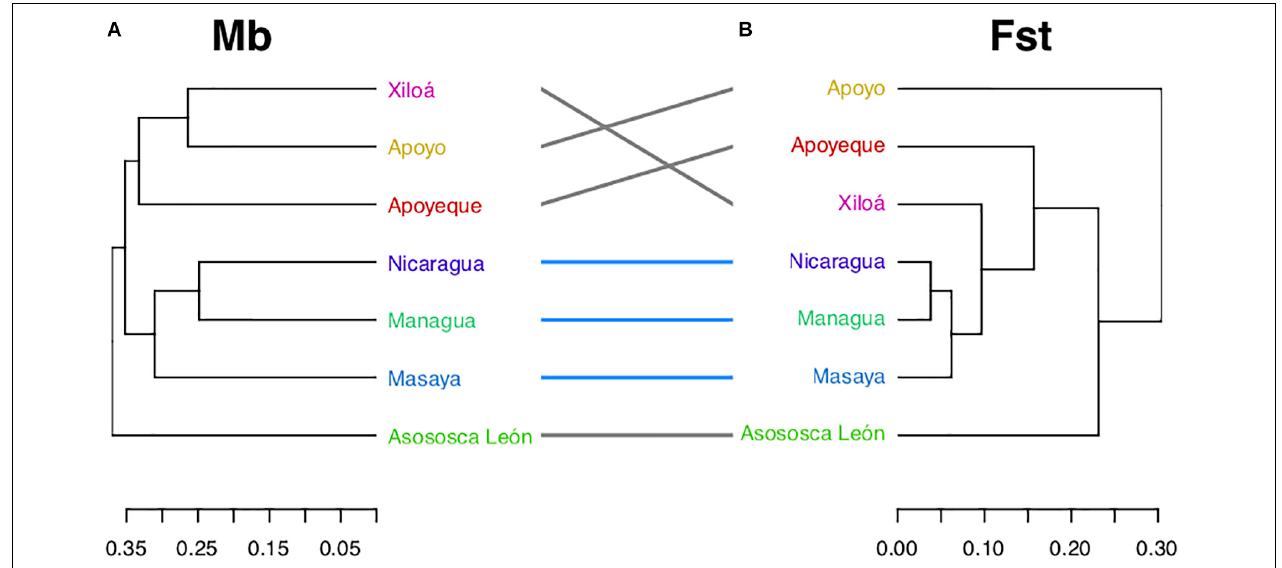
FIGURE 7 | Midas lake cichlid relationships as inferred by their microbiota (Mb), and Fst genetic distances. (A) Microbiota dendrogram according to the lake centroid by mean of Unifrac distances among specimens, (B) dendrogram based on average microsatellites-based Fst distances among lakes from previously published data (Barluenga and Meyer, 2010), largely in agreement with SNPs-based data from Kautt et al. (2018). Common labels (lakes) are connected by lines, whereas lakes in common subtrees are connected by blue lines. The cluster of large lakes (Nicaragua and Managua) with the crater L. Masaya was recovered by both distances.